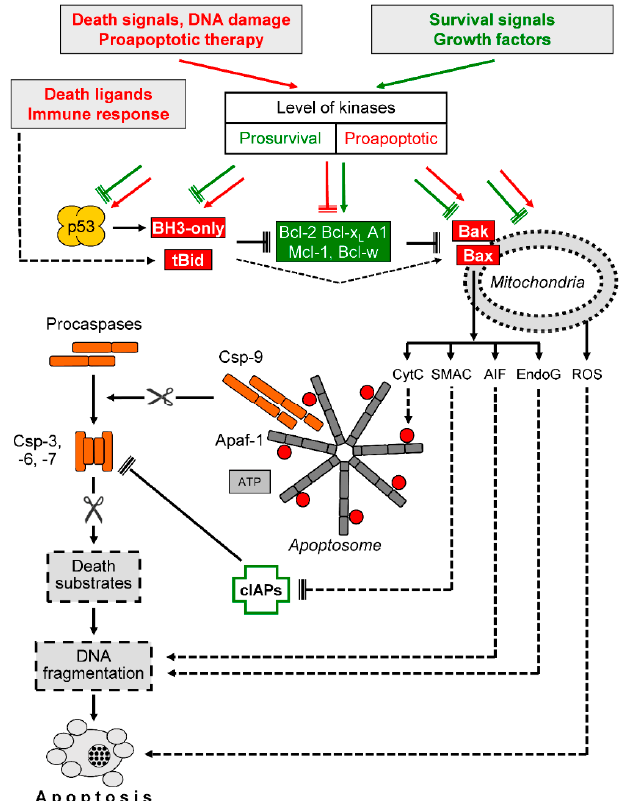
Figure 3. Intrinsic proapoptotic